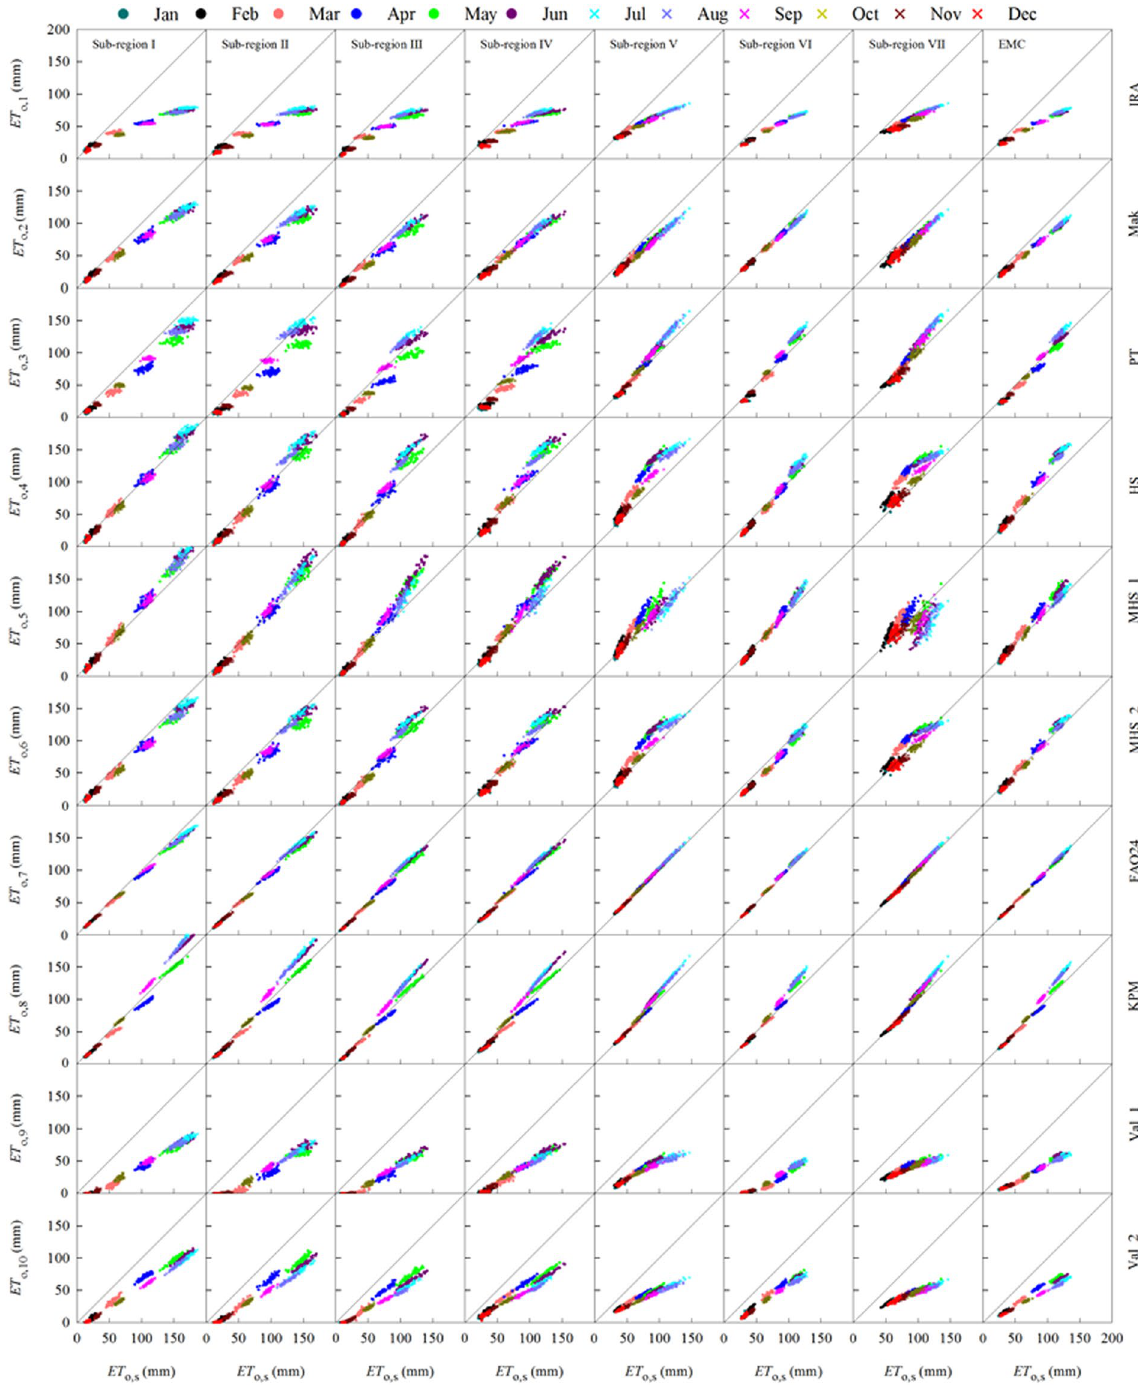
Figure 9. Comparisons of ET o,i and ET o,s in each month and